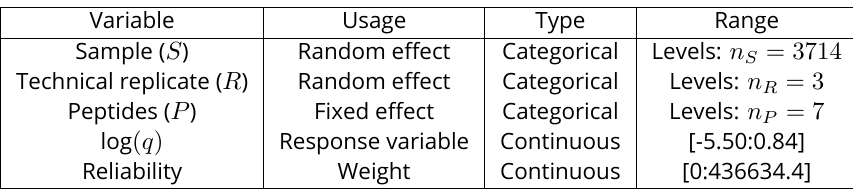
Table 2. Summary of the